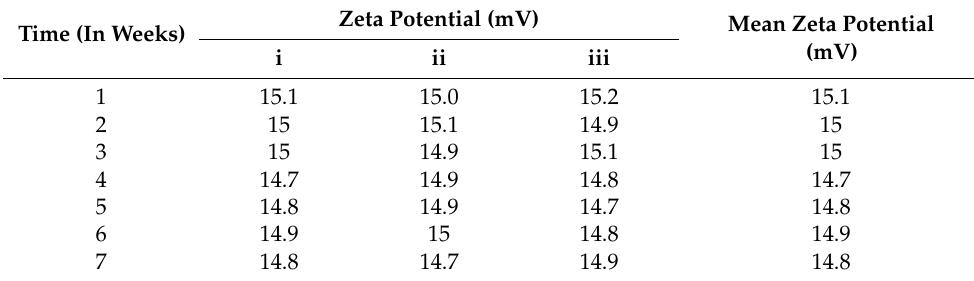
Table 3. Zeta potential of BCA-LDH-C nanoparticles for 7 weeks.